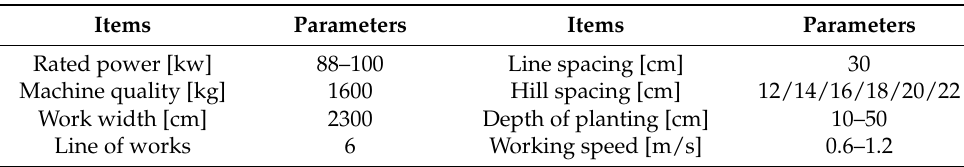
Table 1. Main parameters of rape blanket transplanter.